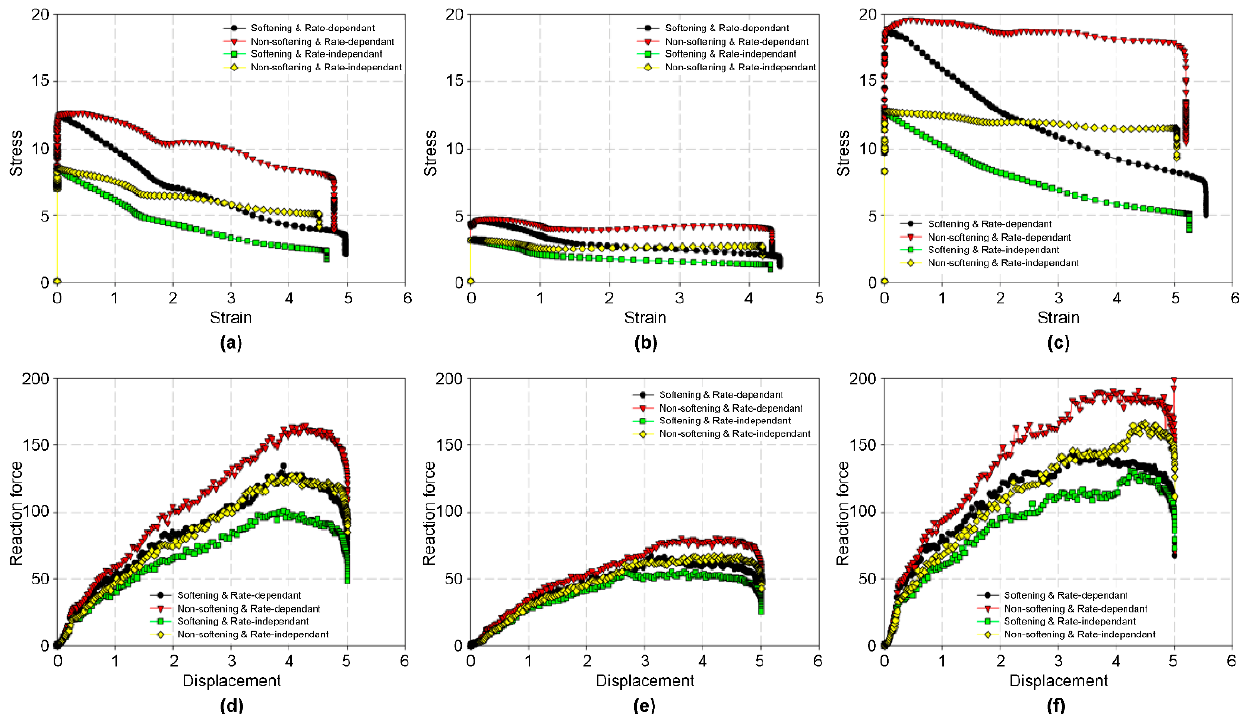
Figure 15. Results of TBSR–VUMAT model according to strain softening and strain rate ( a , d ) 1.1 + 4.5 z, ( b , e ) 1.0 + 0.85z, and ( c , f ) 5 + 2 z.